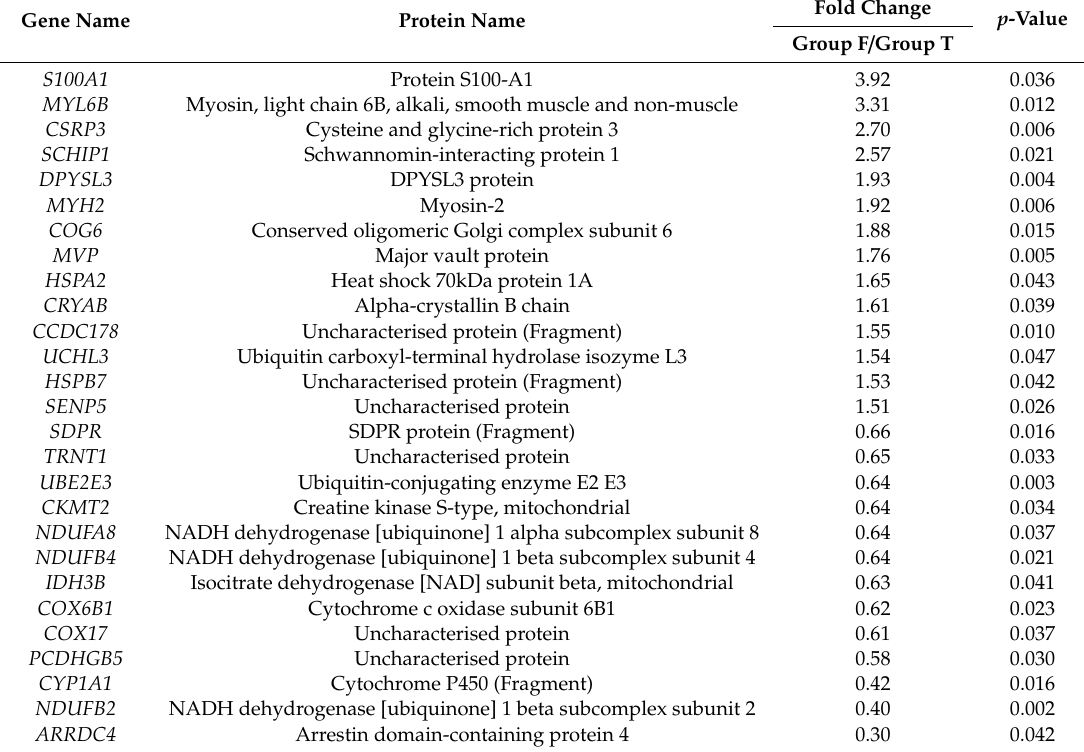
Table 2. Proteins up- and down-regulated between group T (tenderloin steaks from beef cattle) and group F (flank steaks from beef